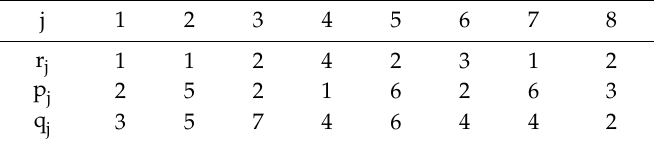
Table 1. Processing times, release times, and delivery times of the example.